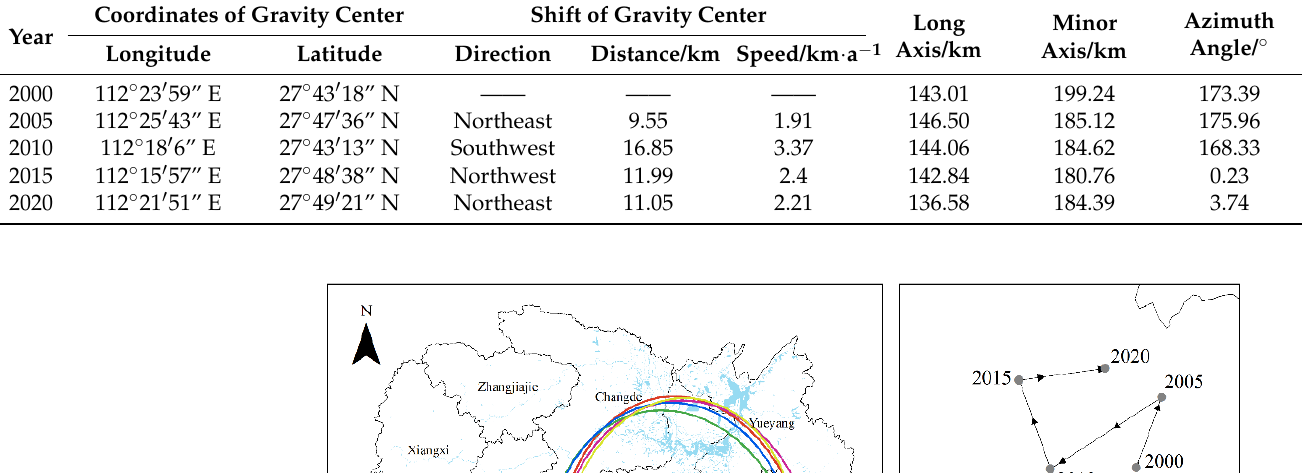
Table 3. Ellipse parameters of carbon emission standard deviation in Hunan Province.